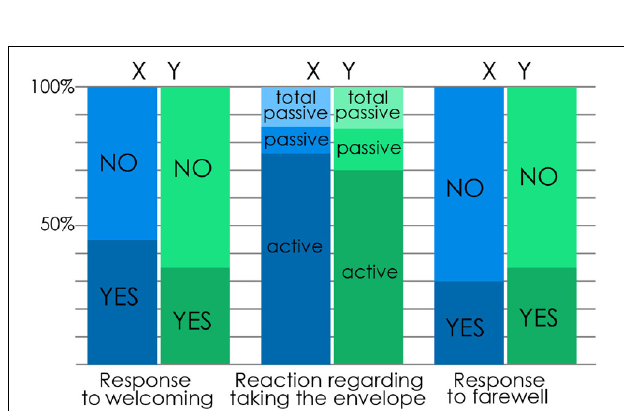
FIGURE 4 | The participants’ response to the robot’s gesture. X participants’ response is in blue and Y participants’ response is in green.